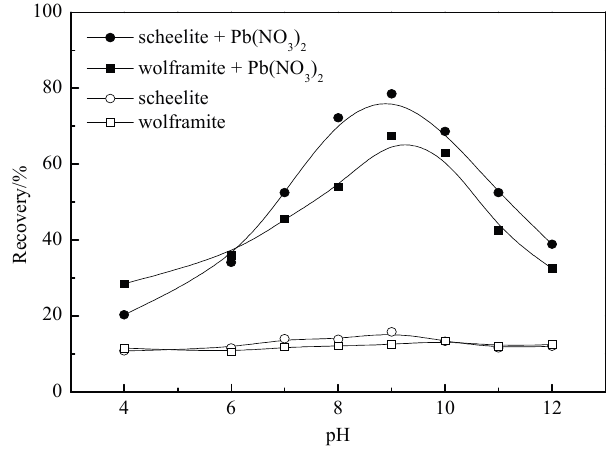
Figure 1. Recovery of scheelite and wolframite as a function of slurry